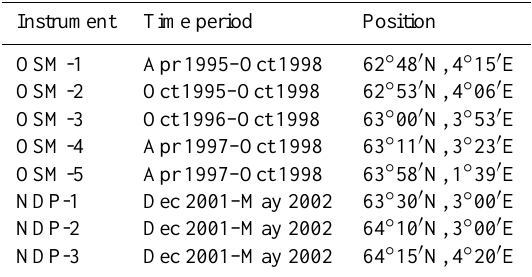
Table 1. Time periods and locations of the current measure- ments used for validation. Locations are also shown in Figs. 1 and 3. OSM-instruments, from Orvik et al. (2001), are current me- tres while NDP-instruments, from the Norwegian Deep Water Pro- at 100m depth.